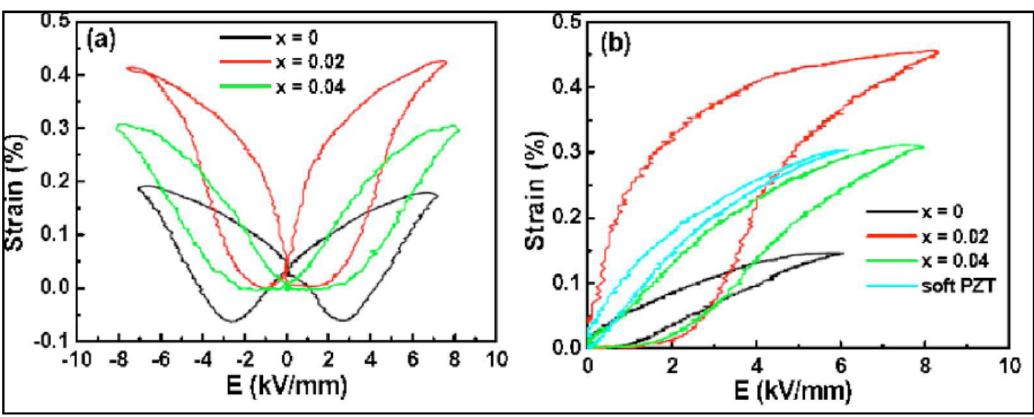
Figure 8. Bipolar ( a ) and unipolar ( b ) strain curves of (0.94 − x)BNT ‐ 0.06BT ‐ xKNN in comparison with a soft PZT (reprinted with permission from reference [113]. Copyright from AIP Publishing LLC 2007).